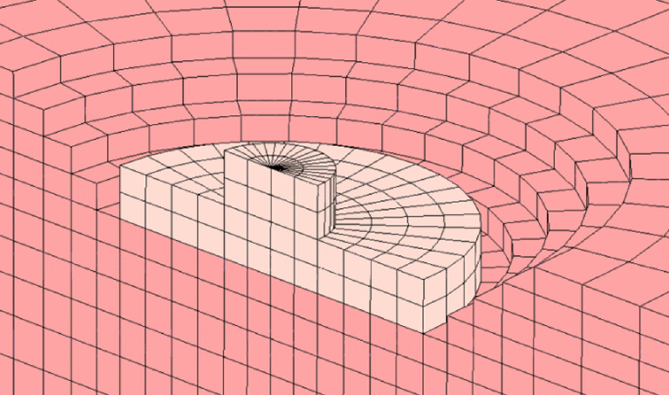
Figure 7. Numerical 3D model of the wind turbine’s foundation during the execution of the circular reinforced concrete footing in the Z-Soil program [77].